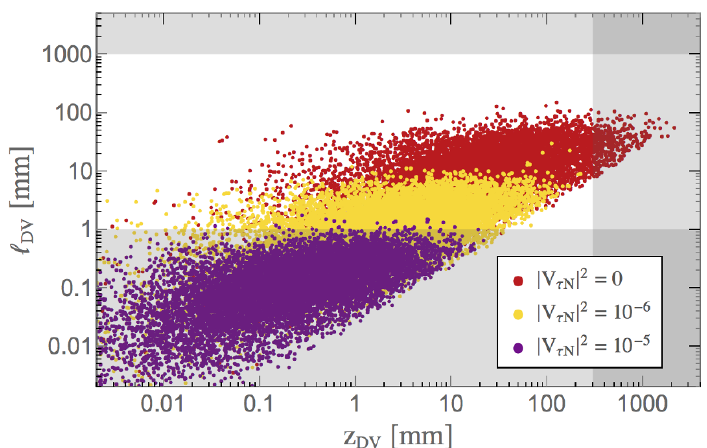
Figure 2 . Distributions of the DV coming from a HNL decay in the ( z DV ; ‘ DV ) plane. The production channel is pp e (cid:6) N , with p e > 25GeV and (cid:17) e < 2 : 5. We (cid:12)x m N = 15 GeV, T ! j j 2 = 10 (cid:0) 7 and V 2 = 0 (red), 10 (cid:0) 6 (yellow) and 10 (cid:0) 5 V eN (cid:22)N = 0 in all the cases, while j V (cid:28)N j j j 2 increases, the HNL becomes more prompt and, therefore, insensitive to the DV (purple). As V (cid:28)N j j searches. The white region is the potential DV